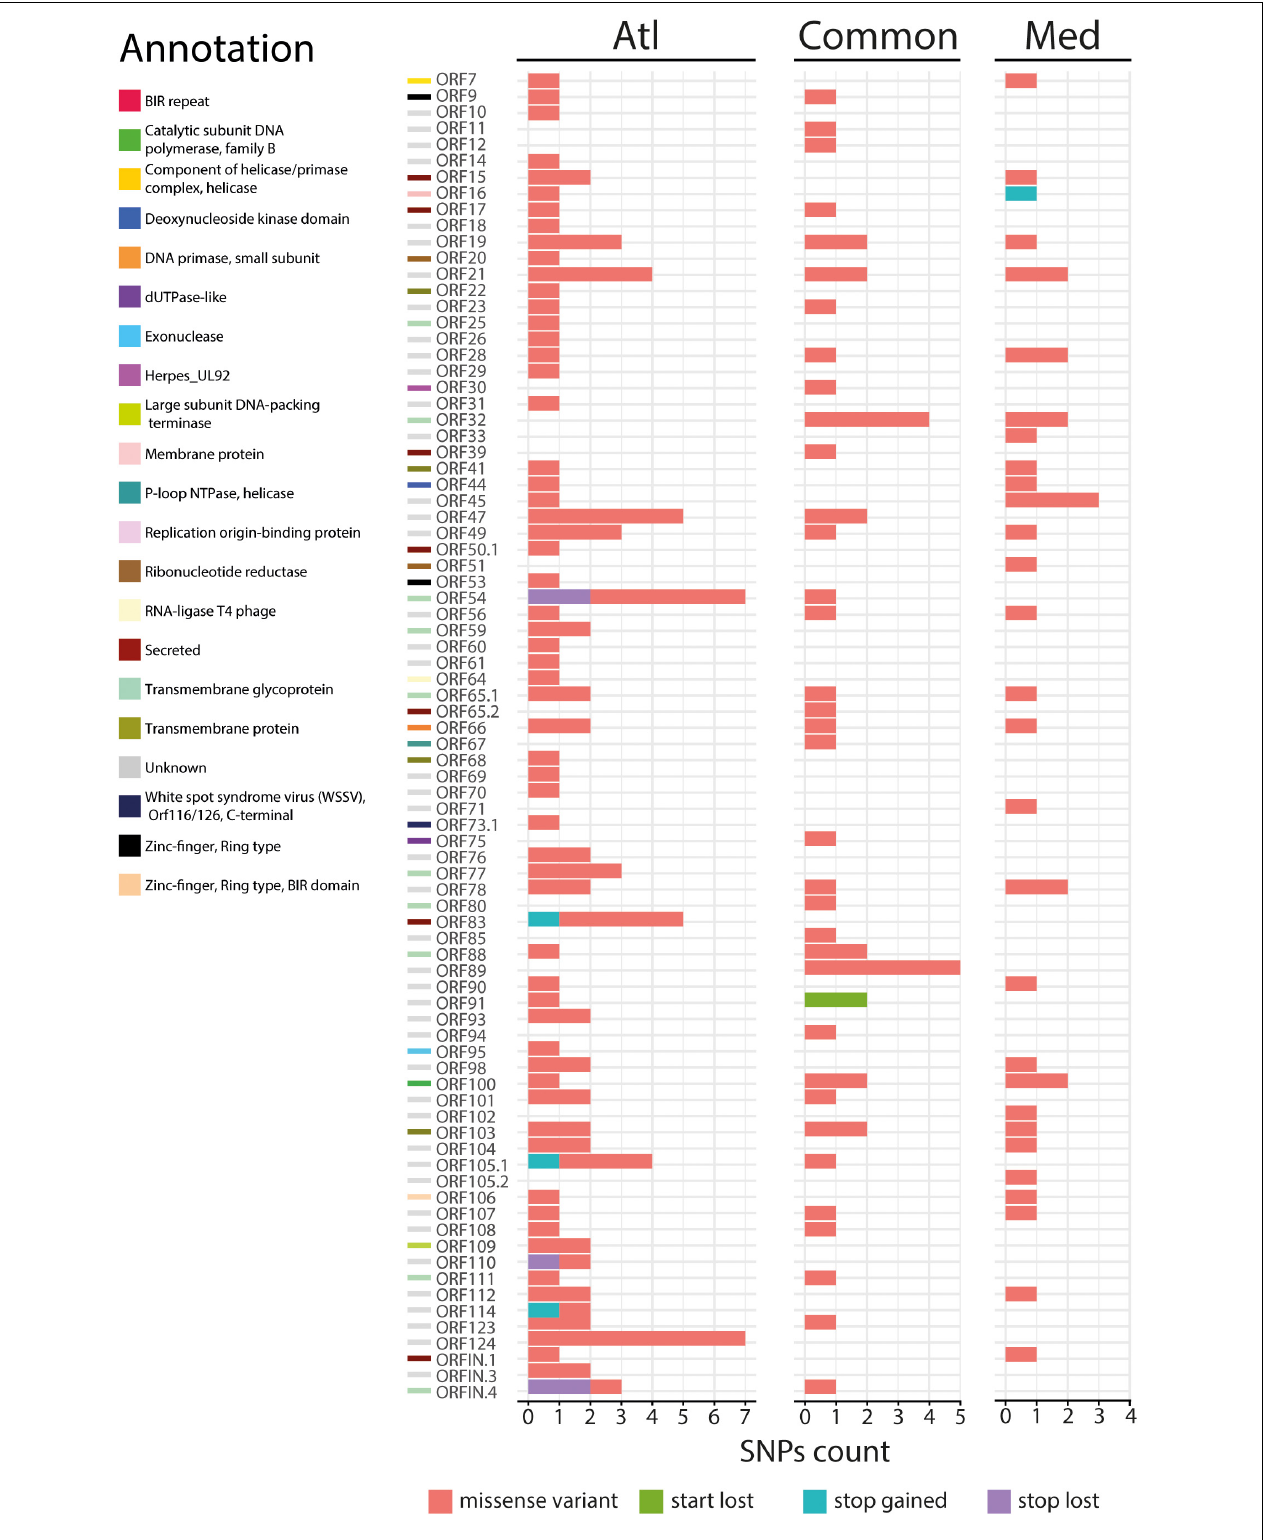
FIGURE 4 | Impact of the 200 nonsynonymous SNPs on the sequence of OsHV-1 µ Var ORFs. Stacked barplot indicates the number of nonsynonymous SNPs ( x -axis) located in each OsHV-1 ORF ( y -axis). Each color indicates a specific mutation effect as indicated at the bottom of the figure. Each line is related to one of the expressed OsHV-1 ORFs. ORF colors (left side) correspond to a functional annotation of the proteins that they encode.